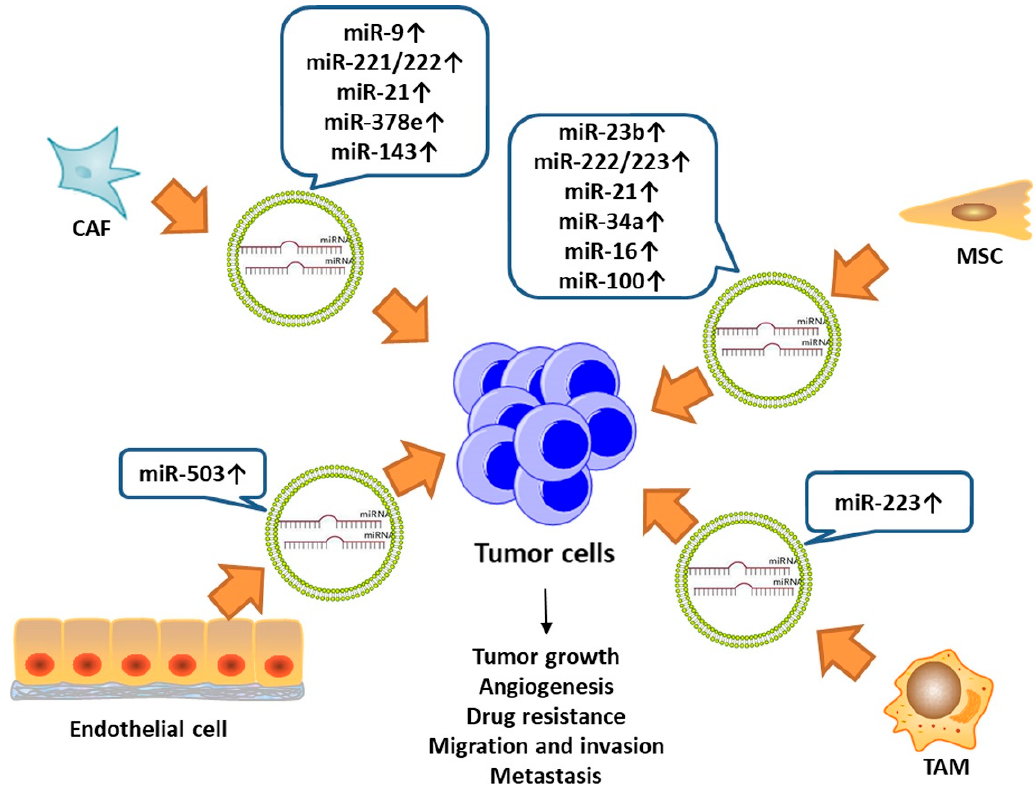
Figure 2. Exosomal microRNAs from stromal cells could enter and function in cancer cells and contribute to cancer progression including tumor growth, angiogenesis, metastasis, etc.